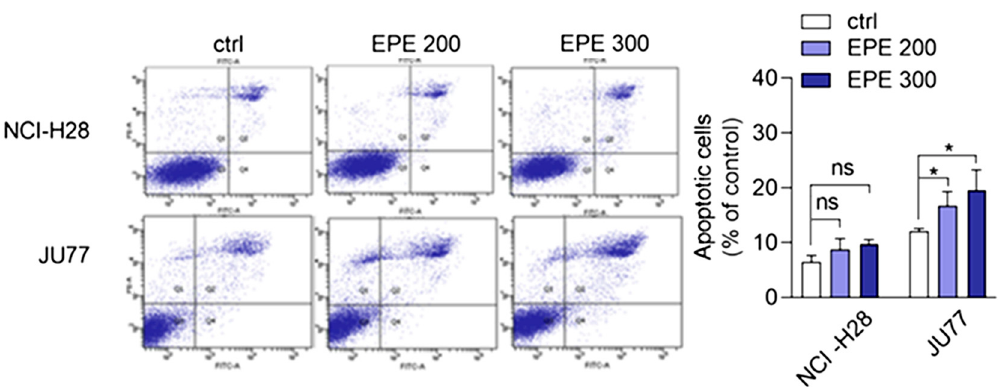
Figure 4. EPE-induced apoptosis in JU77 cells. NCI-H28 and JU77 cells were treated with increasing concentration of EPE (200 µg/mL EPE200; 300 µg/mL EPE300). After 48 h, cells were labelled with